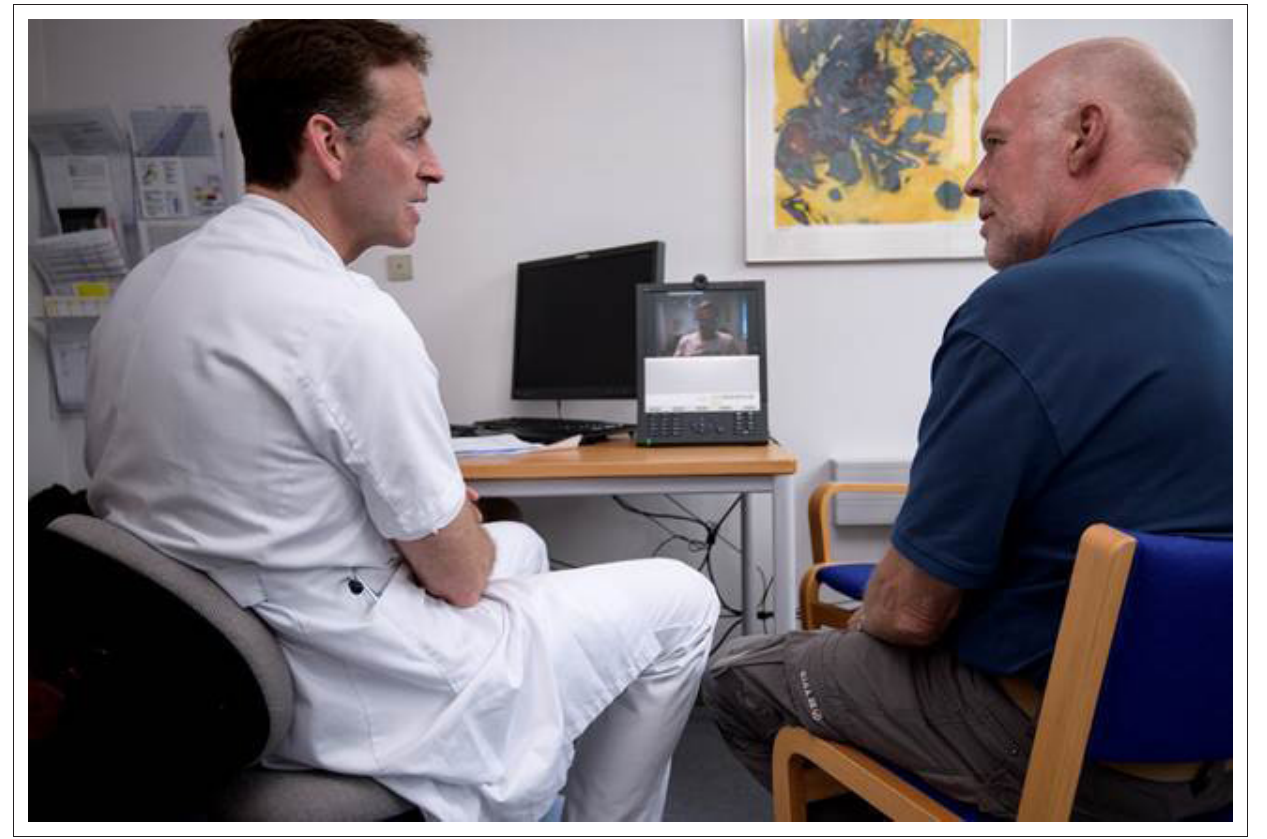
Figure 2 Picture of the video consultation with the patient at the hospital, together with the oncologist. The GP is taking part in the consultation by means of video from his clinic located in the rural region (picture- in- picture feature is turned off in this picture). Reprinted with permission from the Danish Medical Journal, photographer Palle Peter